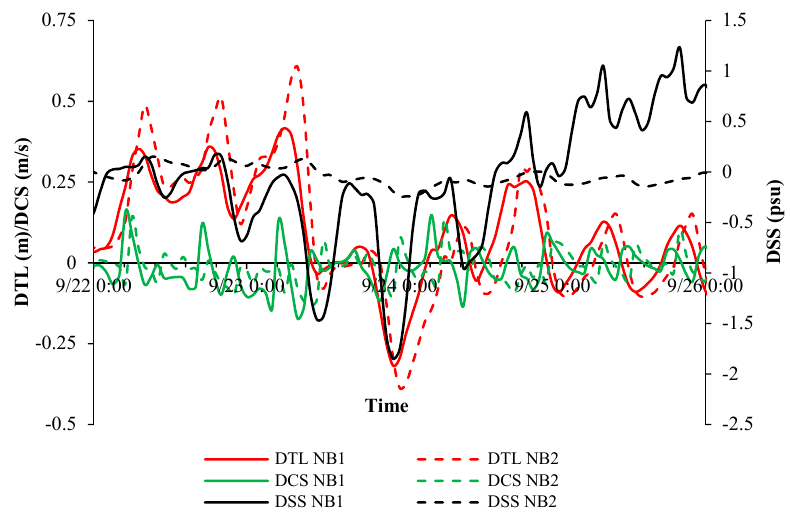
Figure 16. Difference in tidal level (DTL), current speed (DCS) on the surface and surface salinity (DSS), from 22 to 26 September, between the two scenarios of Typhoon Fongwong and normal wind force action at NB1 and NB2 in the NB in 2014.